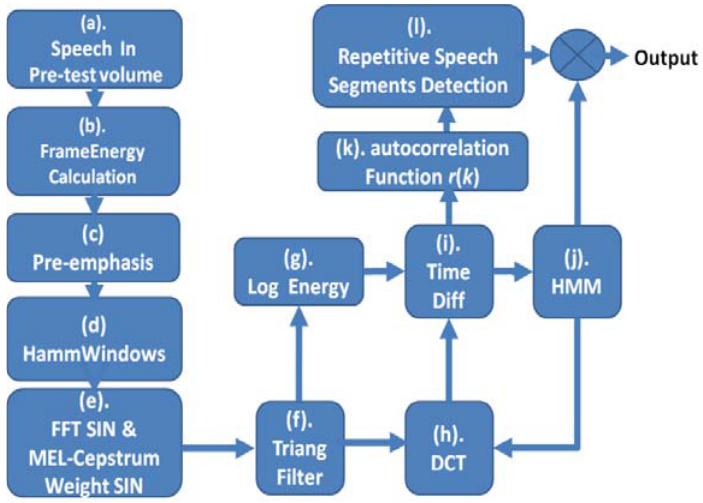
Figure 7. Feature extraction flow chart of Mel-frequency cepstral